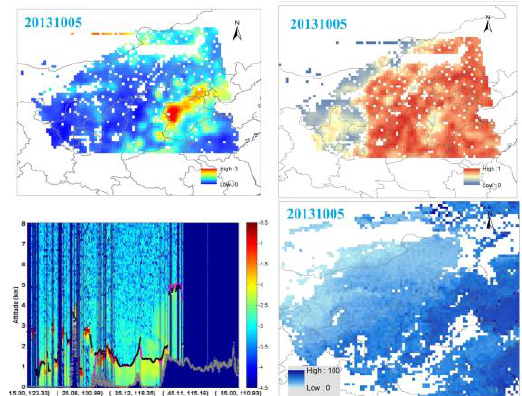
Figure 3 . The retrival distributions of AOD, FMF, PBLH and RH on October 5 th , 2013.